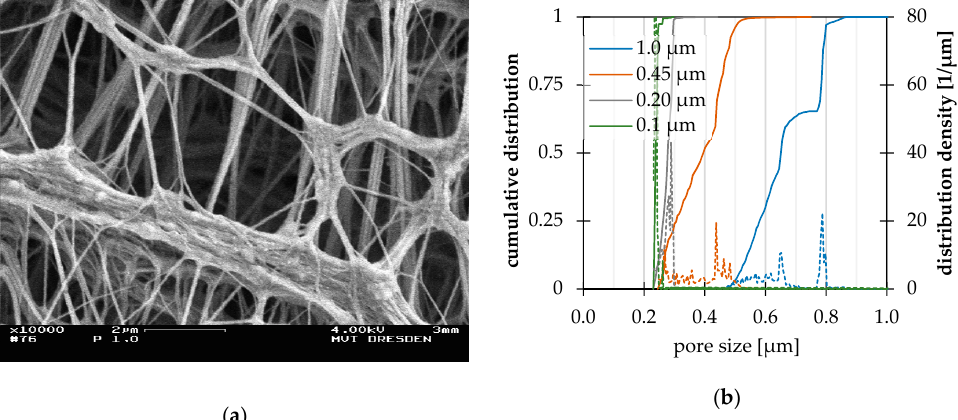
Figure 1. Characterization of OMNIPORE ® polytetrafluoroethylene (PTFE) membrane (1.0 µ m denoted pore size): ( a ) SEM image after sputtering with platinum in argon atmosphere, magnification 10000; ( b ) cumulative pore size distributions and distribution densities obtained by the pore size meter PSM 165 by TOPAS GmbH.